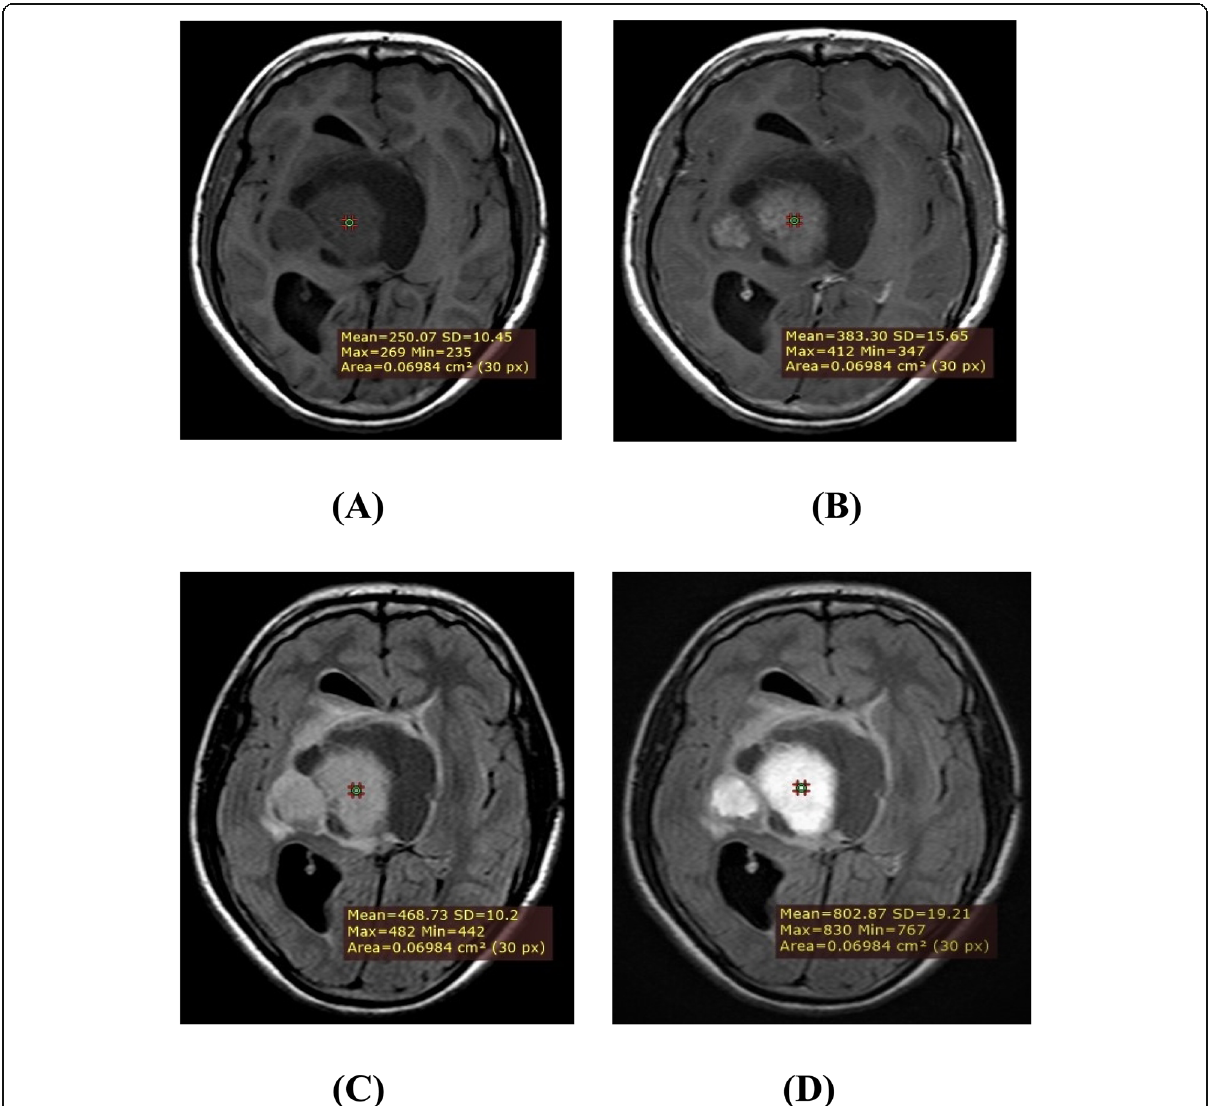
Fig. 5 Male patient aged 15 years with histopathologically proven craniopharyngioma presented on pre and post-contrast T1WI MRI ( A and B respectively) as large well-defined suprasellar cystic lesion with enhancing solid component was noted. The lesion compresses the optic chiasm and third ventricle. On axial pre- and post-contrast FLAIR ( C and D ), qualitative and quantitative enhancement of the solid component was much more extensive in post-contrast FLAIR than in post-contrast T1WI with superior contrast to background ratio in post-contrast FLAIR